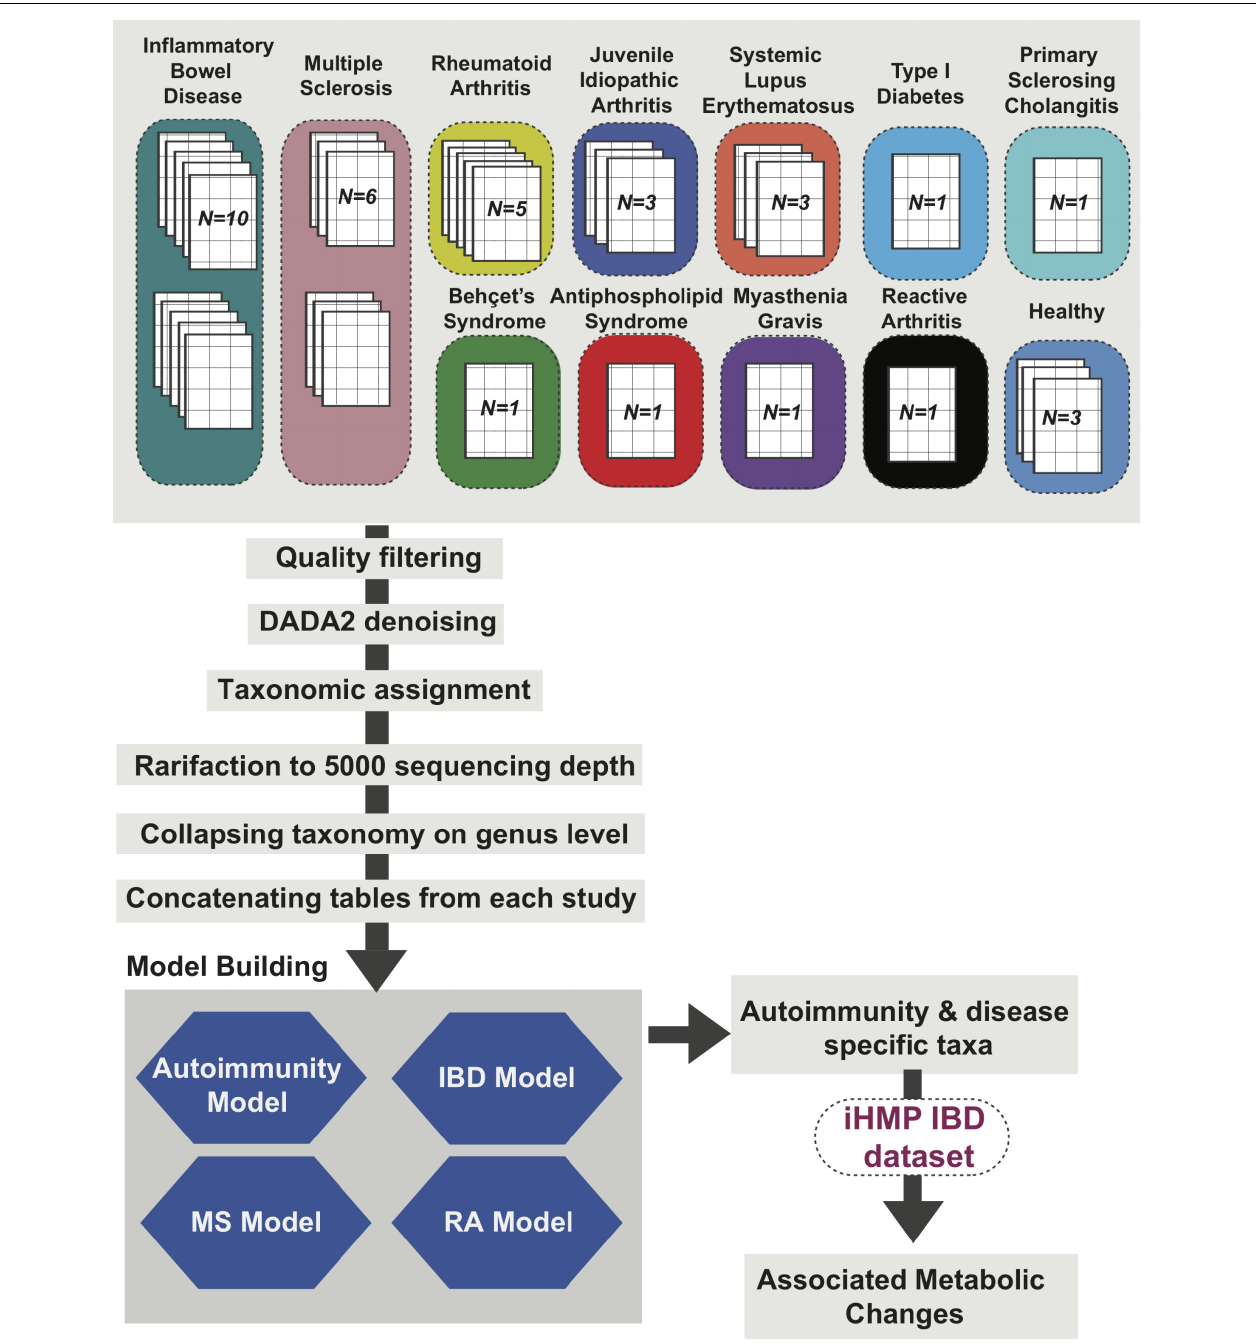
FIGURE 1 | Autoimmunity Analysis Workflow. Thirty 16S rRNA sequencing datasets from studies focused on 12 different autoimmune diseases and three datasets representing healthy (non-autoimmune disease) cohorts were reprocessed using QIIME2 (Bolyen et al., 2018) with data2 denoising and rarified to 5,000 sequence depth. The output species and genus level relative abundance matrices were used to create four machine learning models for (1) general autoimmunity; (2) inflammatory bowel disease (IBD); (3) multiple sclerosis (MS); and (4) rheumatoid arthritis (RA). Top ranked features from these models were identified and metabolic changes associated with these taxa of interest were assessed using the IBDMDB dataset (Proctor et al.,